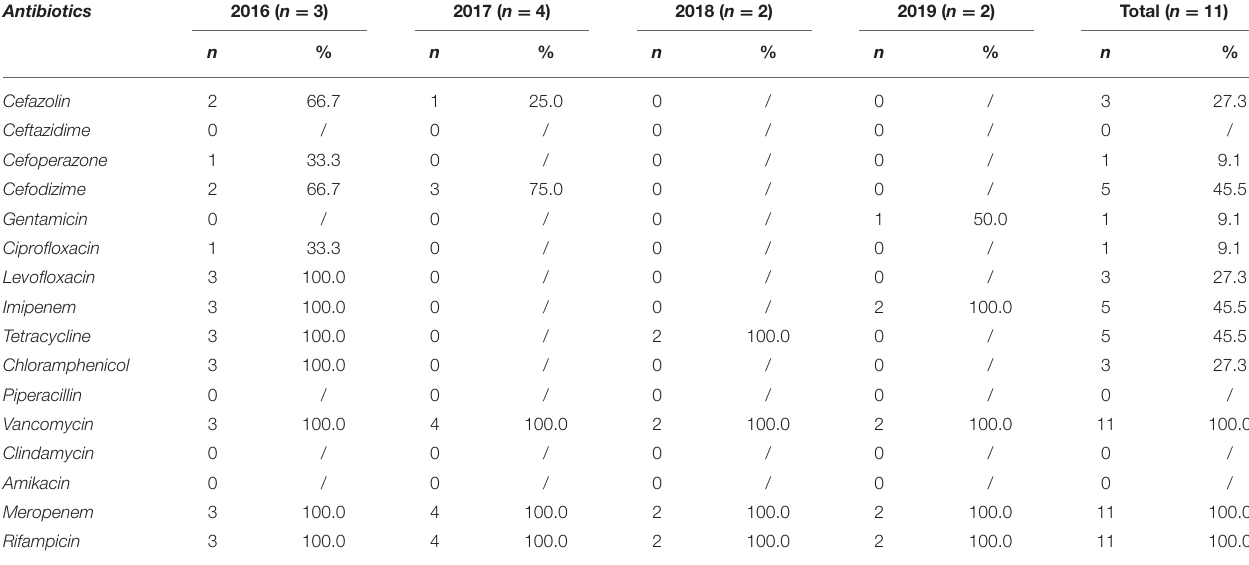
TABLE 4 | Susceptibility of Enterococcus pathogens to antibiotics.